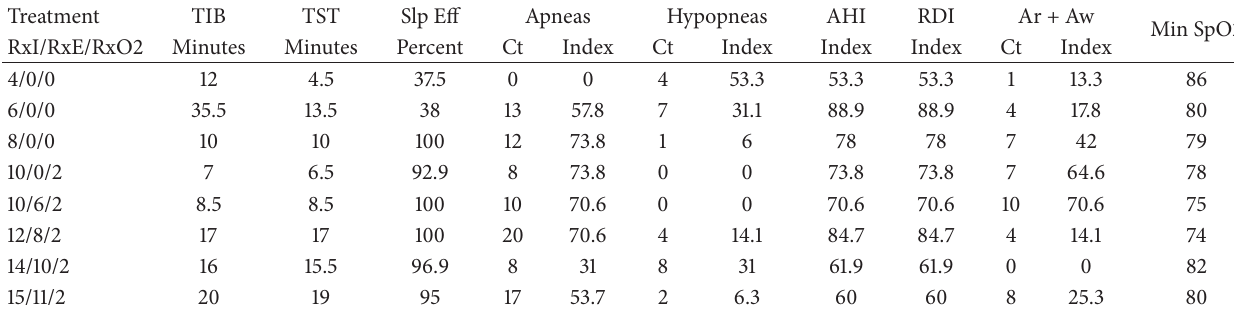
Table 3: Treatment parameters and results.